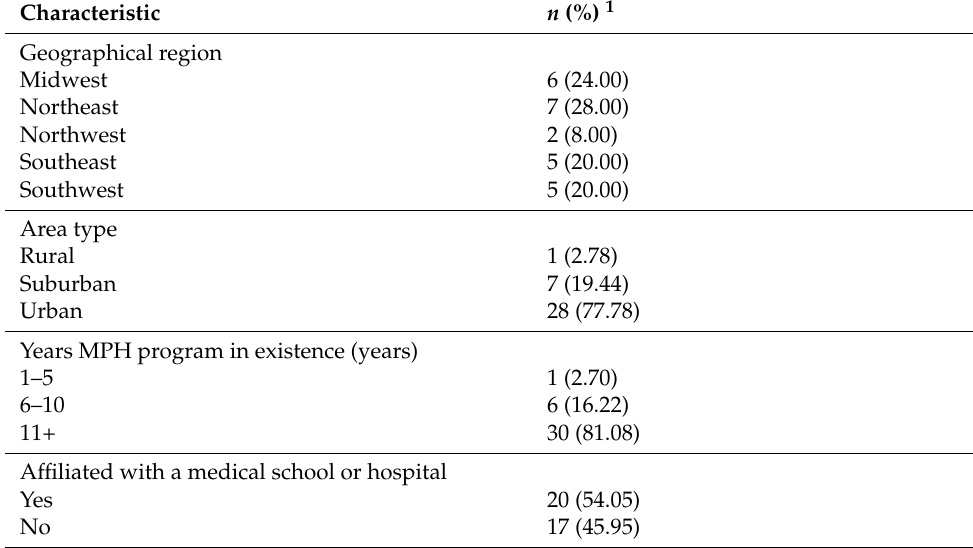
Table 1. Survey demographics.